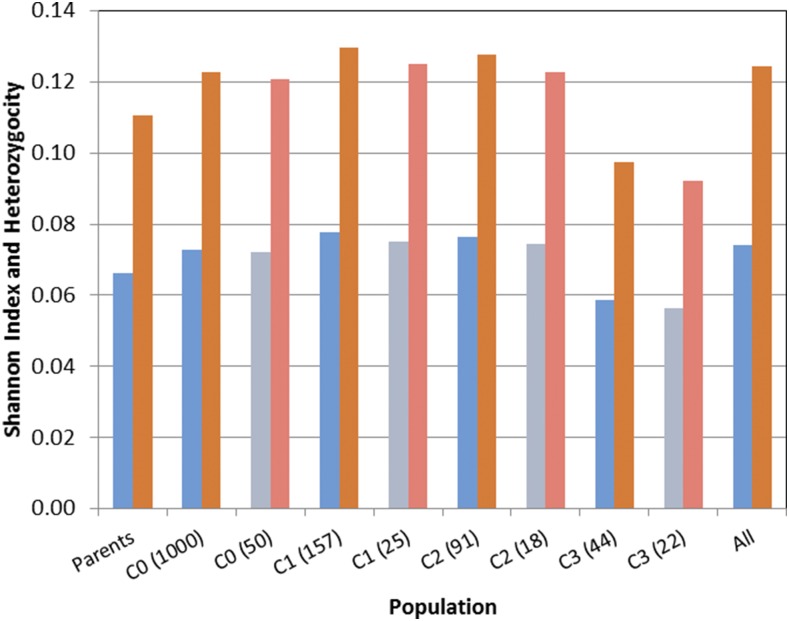
Bar-plot of the Shannon Diversity Index (blue) and heterozygosity (brown and light pink) for the original parents, individuals from cycles C0–C3 and the selected entries in light blue and light pink.